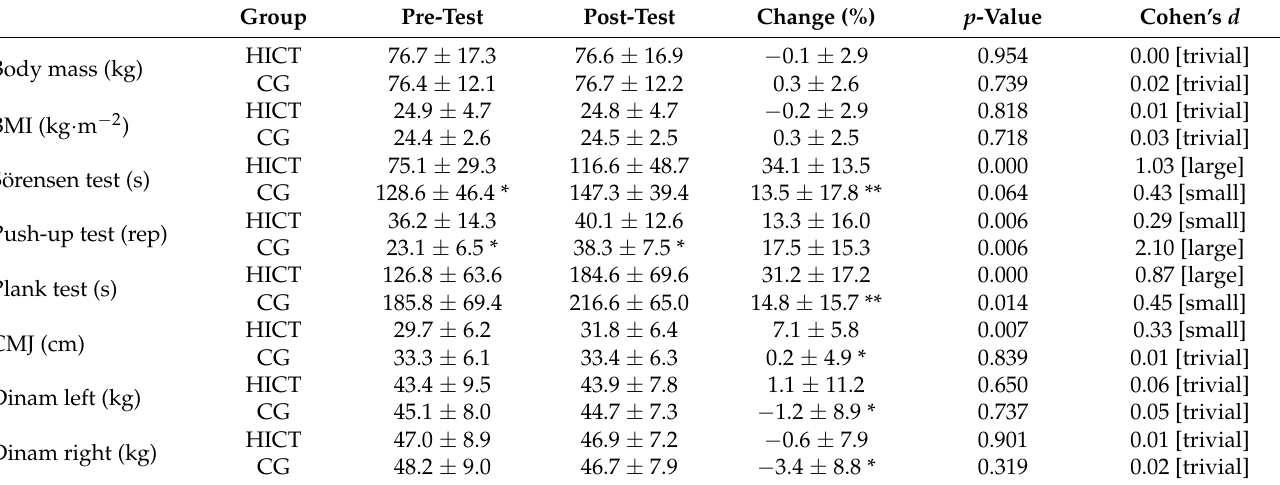
Table 3. Results of anthropometric and muscle strength fitness tests (mean ± SD ).